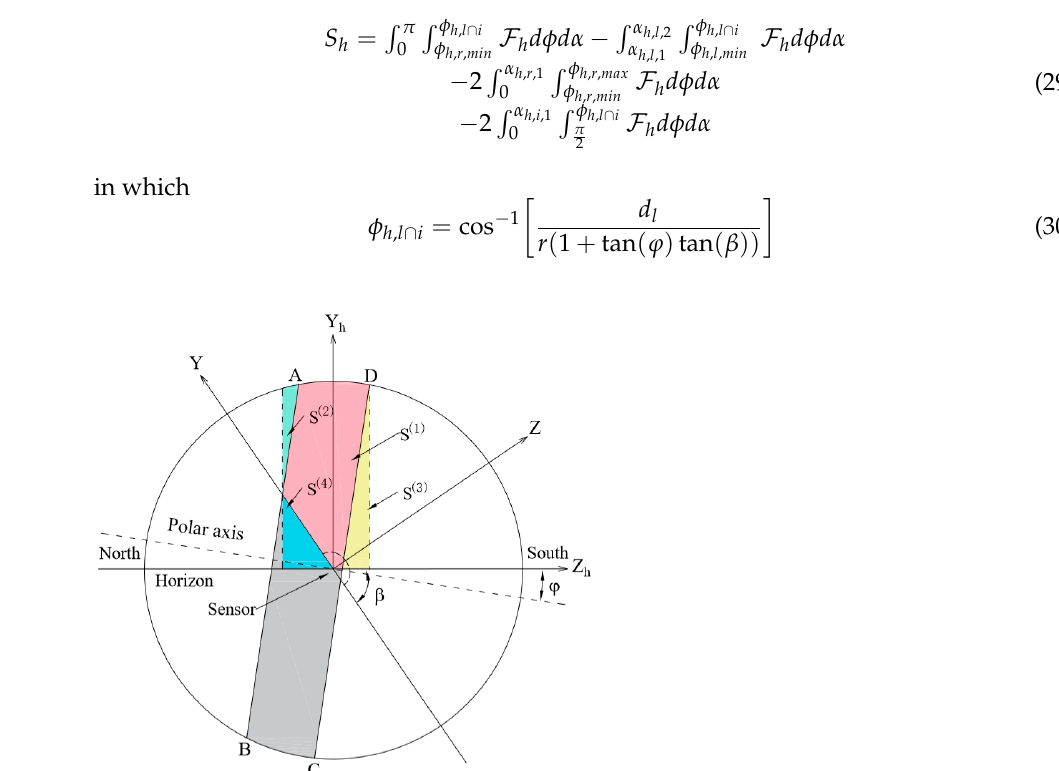
≥ φ ≥ φ h , l , max h , l ∩ i h , l , min .